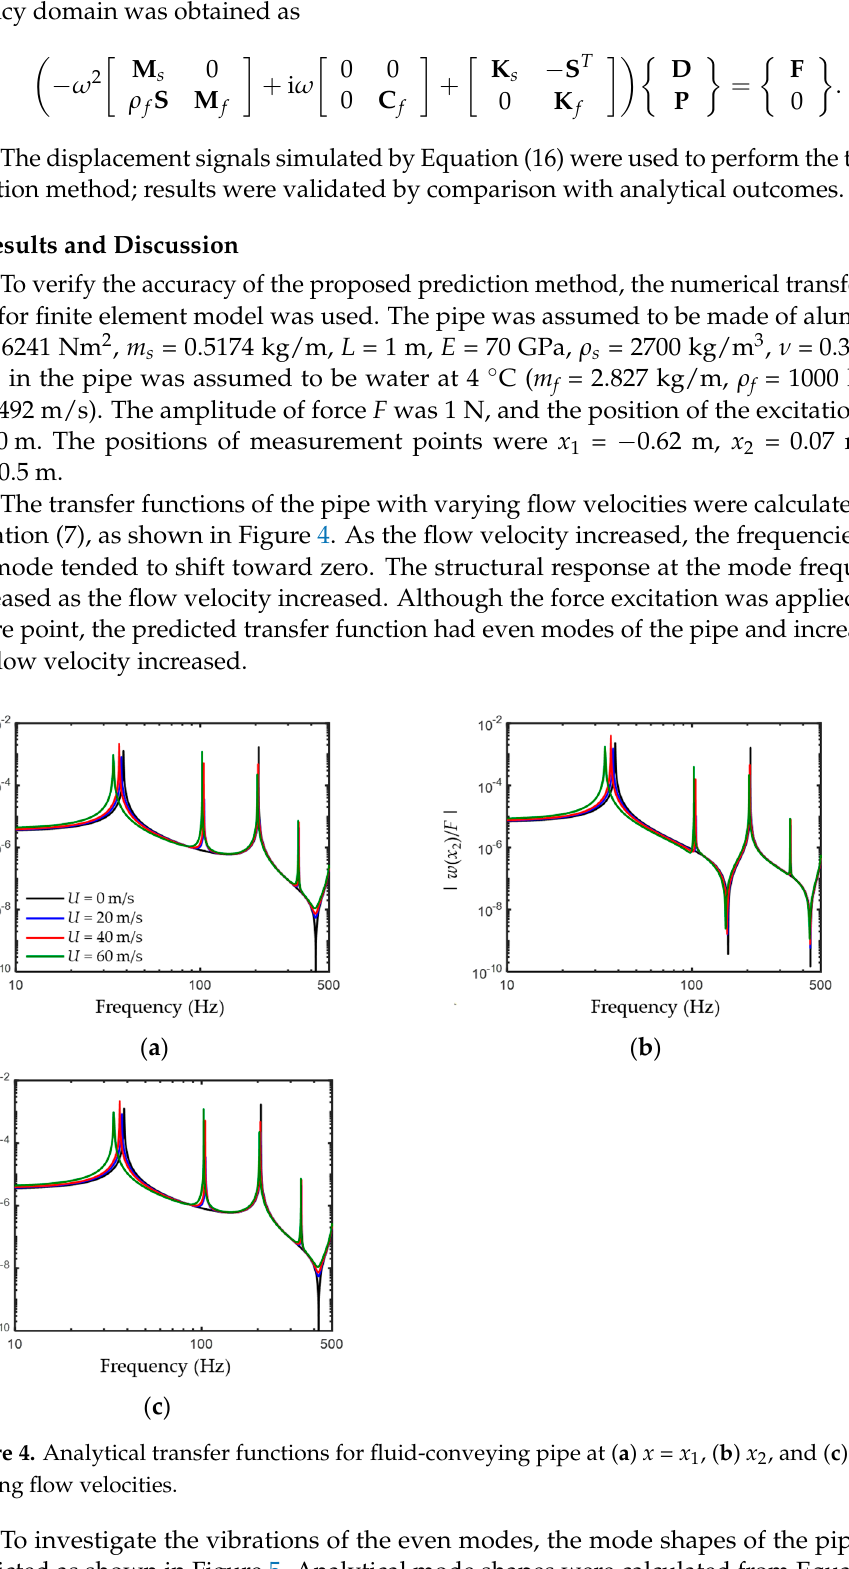
( d ) Figure 5. Analytical mode shapes of the fluid pipe when the flow velocity increased: ( a ) 1st, ( b ) 2nd, ( c ) 3rd, and ( d ) 4th mode shape.